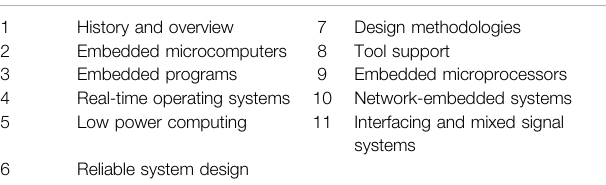
TABLE 2 | Knowledge area in an embedded system (Dick,